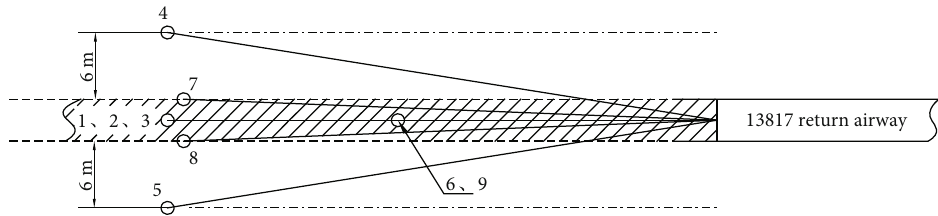
Figure 17: 13817 return airway drainage borehole layout